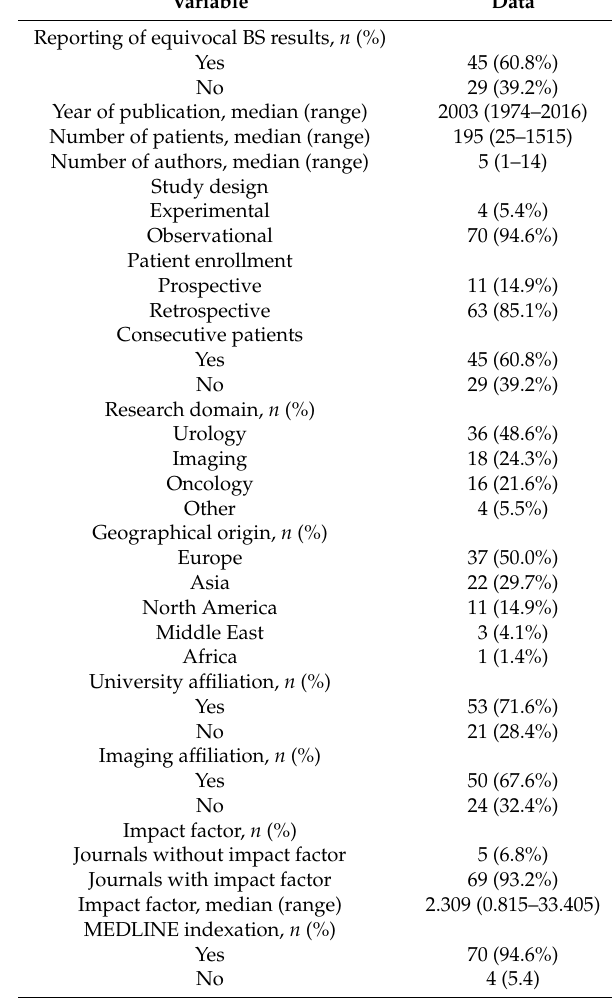
Table 1. Study demographics of the 74 included papers.